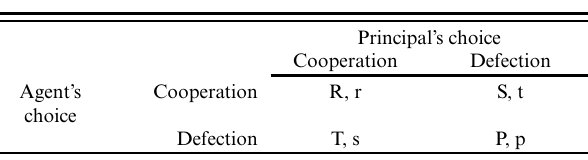
Table 6 . Payoff table.